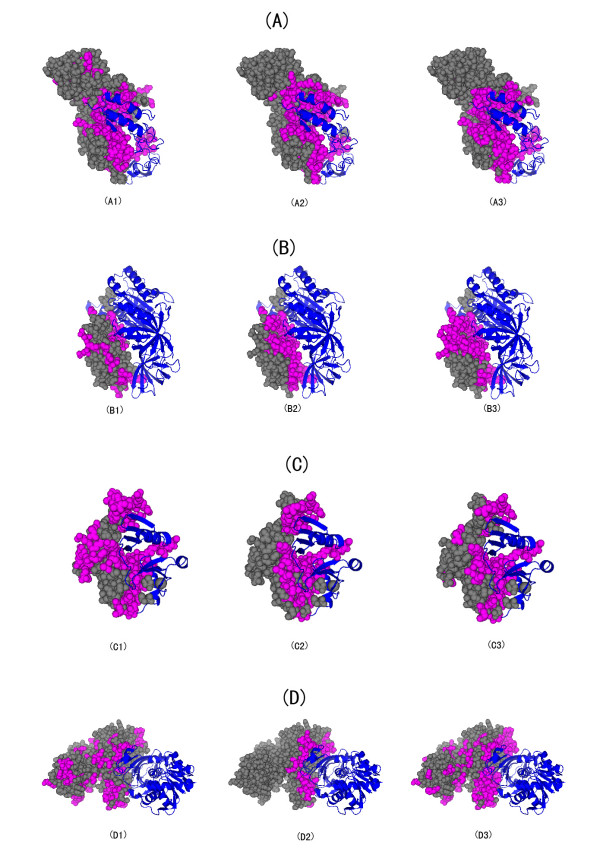
Sample predictions. One protein is selected from each complexes and shown in sub-figure (A), (B), (C) and (D). The PDB IDs and chain identifiers are 1bplB, 1ijeB, 1lqpB and 1j0xO respectively. The interface residues are depicted with purple colour. For each sub-figure, the true interfaces are shown in the center picture. The left picture gives the results predicted by the second SVM, which takes residue interface propensities as an extra feature. The right picture gives the results predicted by the third SVM, which takes binary profile propensities as an extra feature.